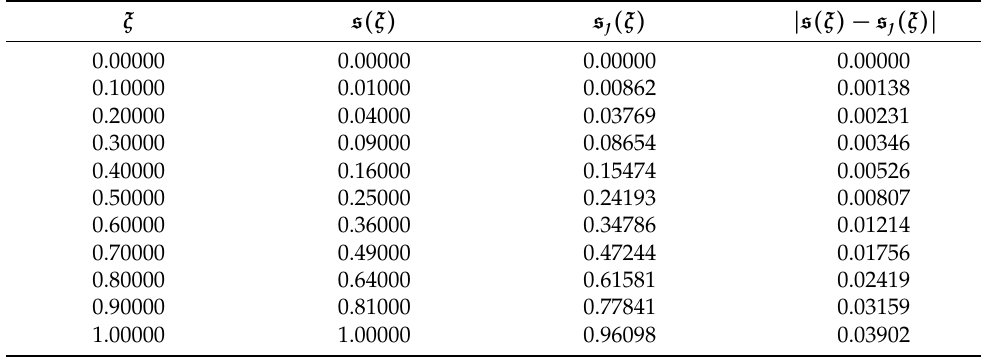
Table 1. The numerical and exact solution using the matrix approach